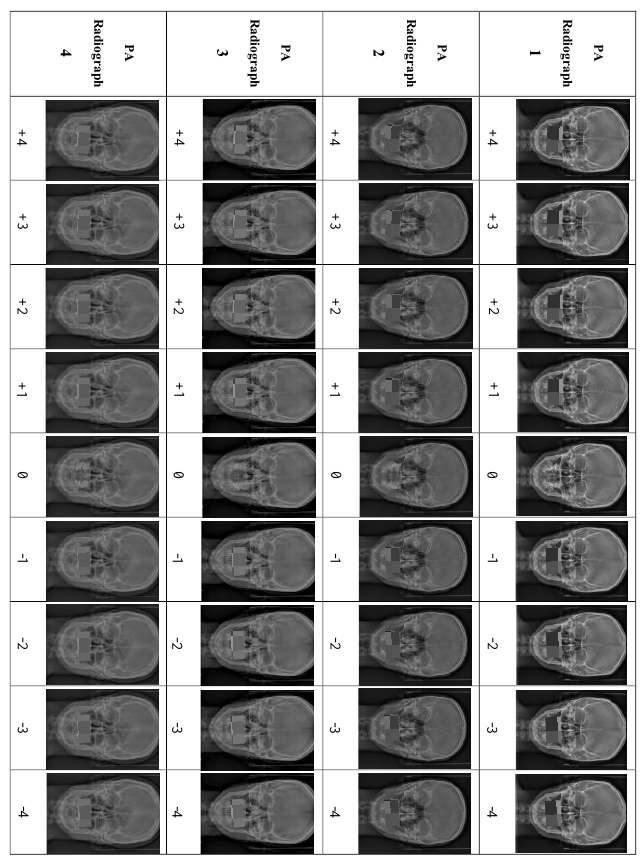
Figure 1. Illustration of the manipulations of all the PA cephalometric radiographs, +1° to +5° (OC at the left side), and − 1° to − 5° (OC at the right side).